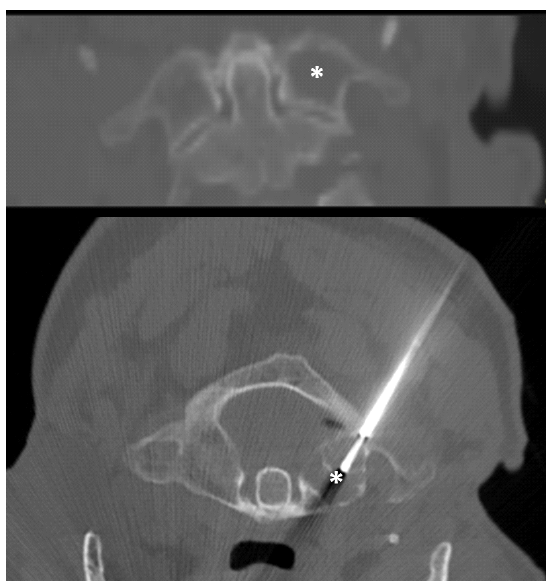
Figure 2. A 73-year-old man. CT frontal view ( Up ) showed a mixed lesion (mostly lytic, shown in asterisks) of the left lateral mass of the atlas. CT-guided biopsy was performed with a posterior